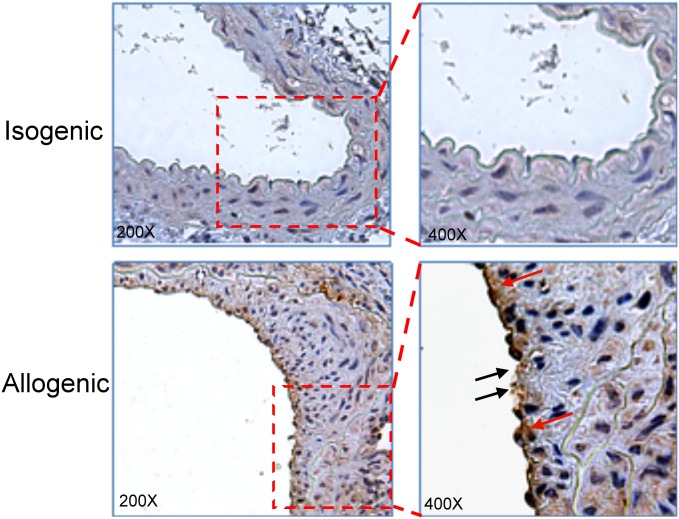
Apoptosis of ECs in an allograft vessel.Recipient and donor aortic sections stained for activated caspase-3 at 3 wk posttransplantation. Red arrows indicate activated caspase-3-positive cells; black arrows indicate fragmented and condensed DNA as well as apoptotic membrane blebbing of the endothelium. The square insert indicates the magnified area.